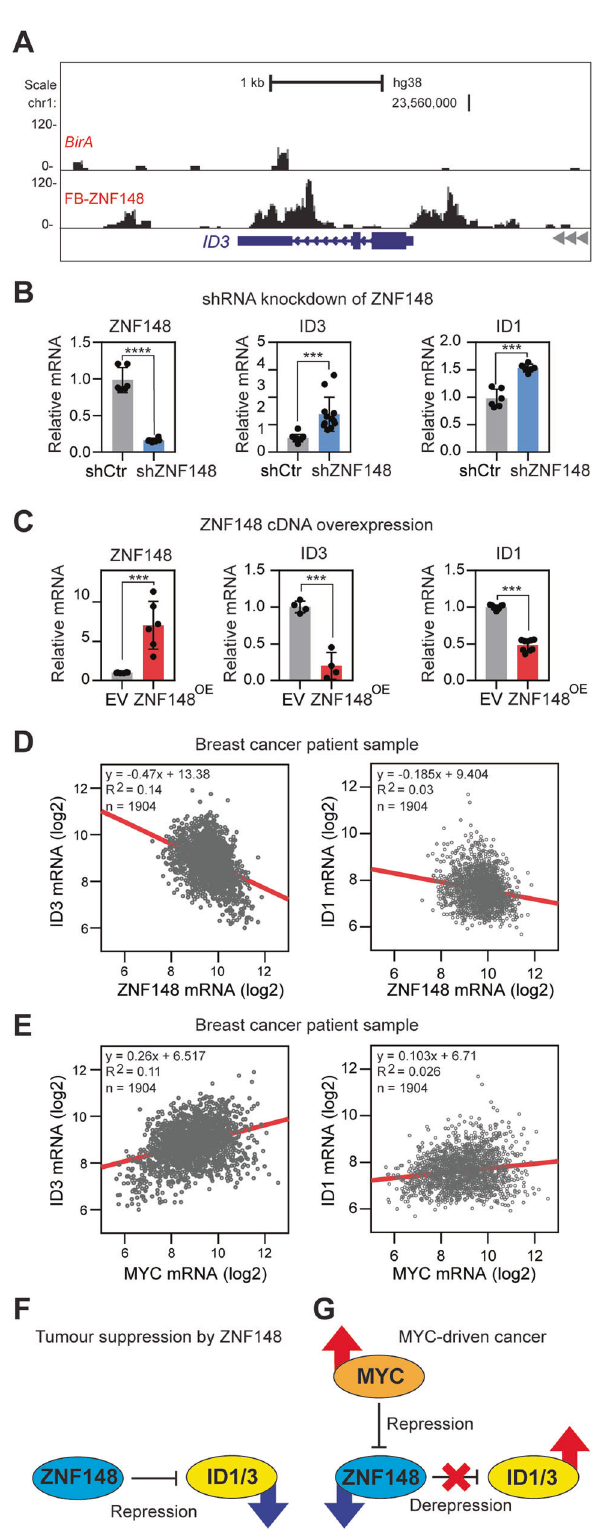
particular, is a highly metastatic TNBC cell line with pronounced MYC-driven cancer stem cell features [59, 60]. Oncogenic MYC alters global transcriptional programs to drive stem cell traits in cancer [11, 61, 62], while concomitantly downregulating tumor suppressor genes and cell cycle regulators